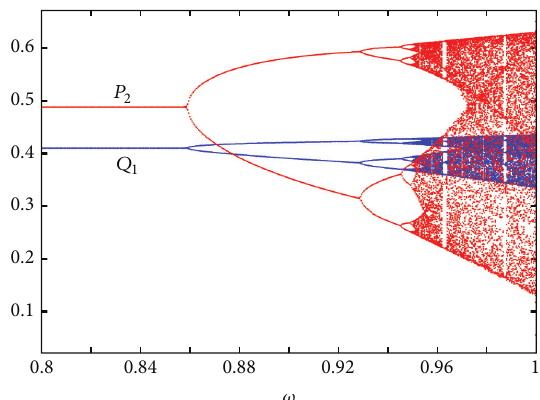
Figure 11: Bifurcation diagrams of system (11) for 𝛼 = 1.5 , 𝛽 = 2.9 , = 1 and 𝜔 0.8 to 1 . 𝜔 1 2 varying from